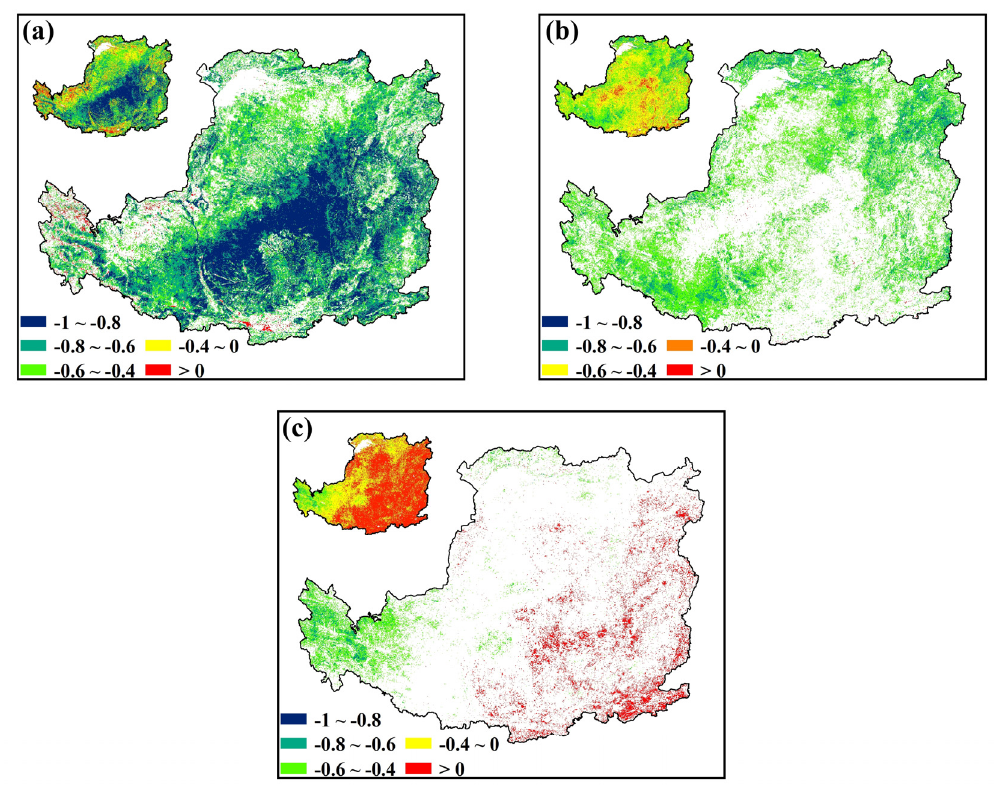
Figure 6. ( a ) The spatial distribution of the partial correlation coefficients between the ESI and LAI, eliminating the influences of precipitation and temperature; ( b ) the spatial distribution of the partial correlation coefficients between the ESI and precipitation, eliminating the influences of LAI and temperature; ( c ) the spatial distribution of the partial correlation coefficients between the ESI and temperature, eliminating the influences of LAI and precipitation. The small insets in all plots show the spatial distribution of the partial correlation coefficients, while the large insets show only the partial correlation coefficients with a statistically significant level of 0.05.